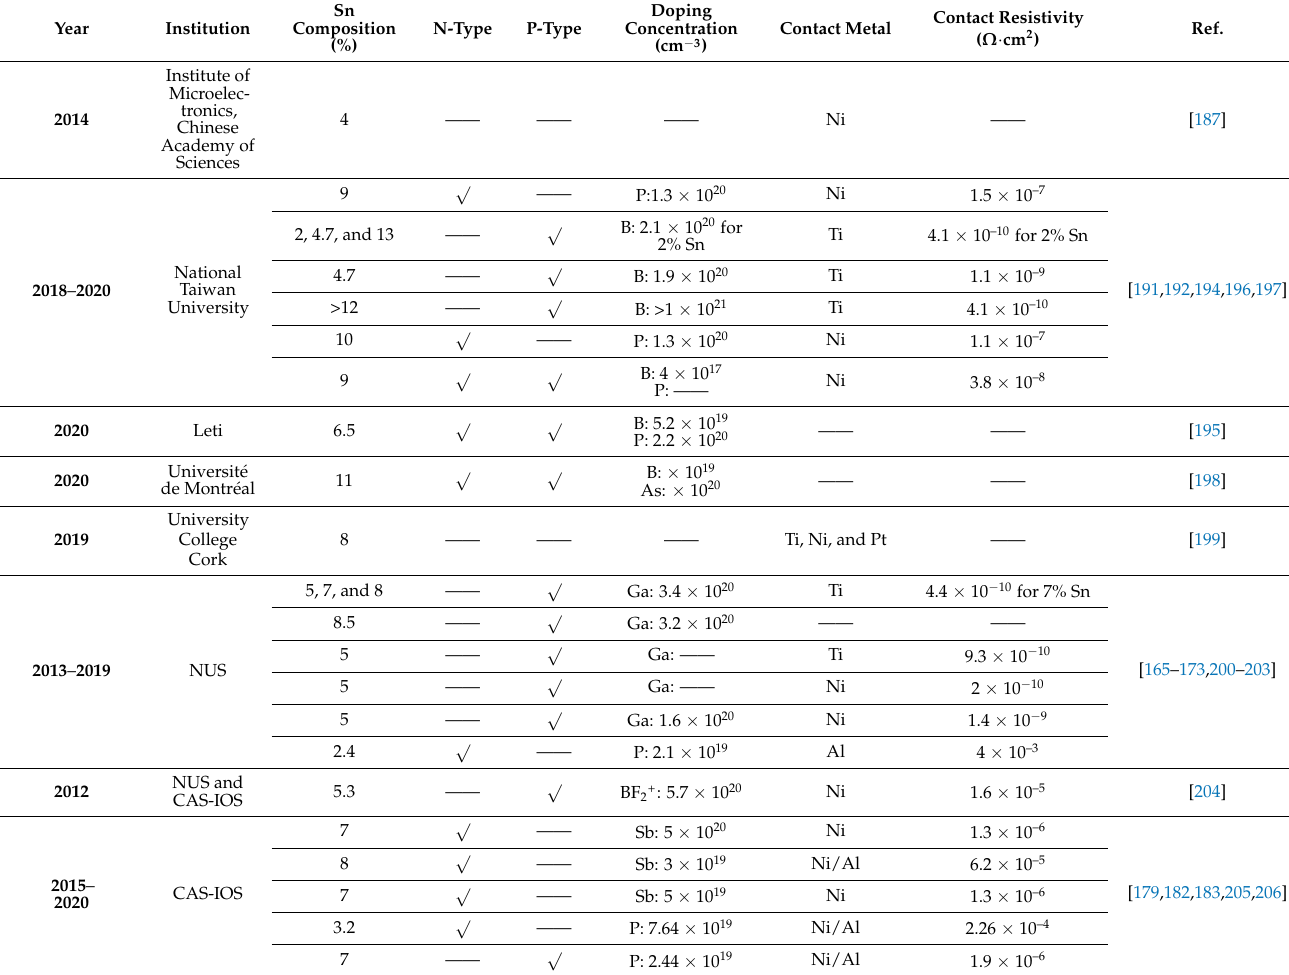
Table 3. Summary of reported B-doped GeSn, P-doped GeSn, and As-doped GeSn in terms of institution, Sn content, doping type, doping concentration, and contact metal.